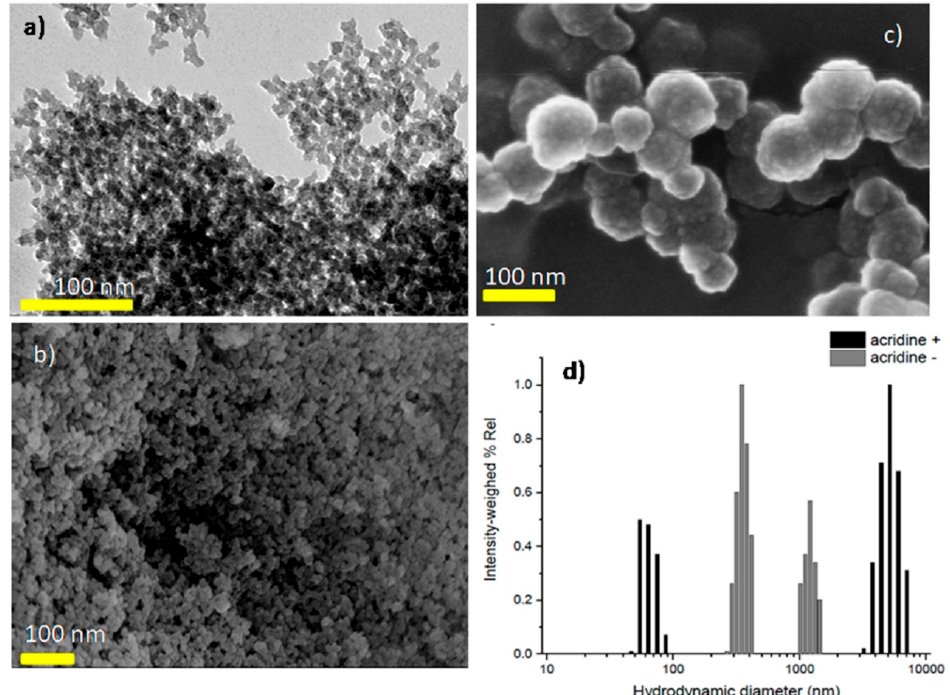
Figure 2. ( a ) TEM and ( b ) FE-SEM images of UiO-66_N obtained by hydrothermal synthesis; ( c ) spherical particles aggregates of smaller UiO-66_N@Acr obtained by dialysis; and ( d ) photo correlation spectroscopy measurements depicting hydrodynamic populations for UiO-66_N (grey) and UiO-66_N@Acr (black) in pure water at 20 °C.